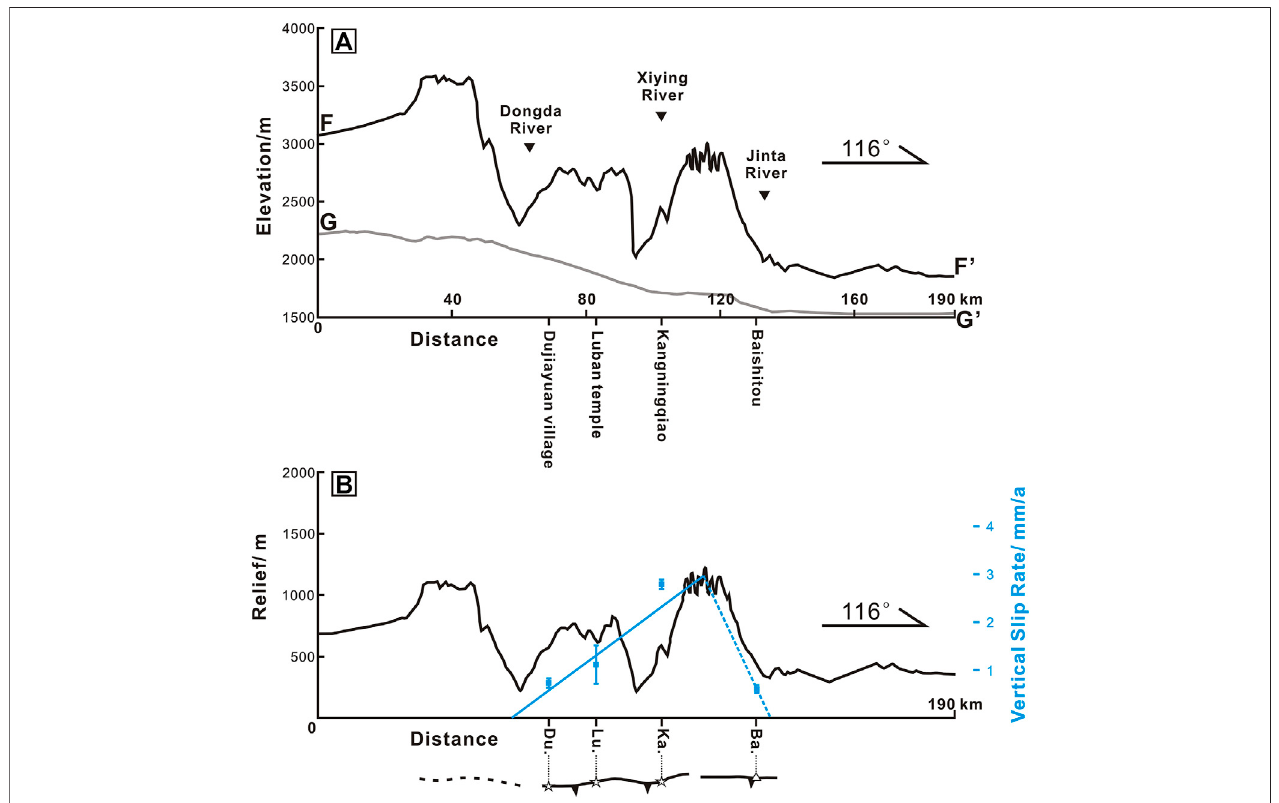
FIGURE7|(A) Inordertoobtainthereliefpro fi le,weextractboththealongcrestpro fi leoftheYongchangnanShanandaparalleledpro fi lealongtheHexiCorridor. The indication for swath pro fi les F-F ′ and G-G ′ is marked in Figure 1C . For F-F ′ , maximum elevation is taken for each increment along the swath pro fi le. For the terrain pro fi leoftheHexiCorridorbasinG-G ′ ,minimumelevationineachincrementistaken. (B) Thereliefpro fi leisobtainedbydifferencingthecrestpro fi le(F-F ′ )andtheterrain pro fi le of the Hexi Corridor (G-G ′ ). We also project the vertical slip rates (blue in color) at each surveyed site on the coordinate system.